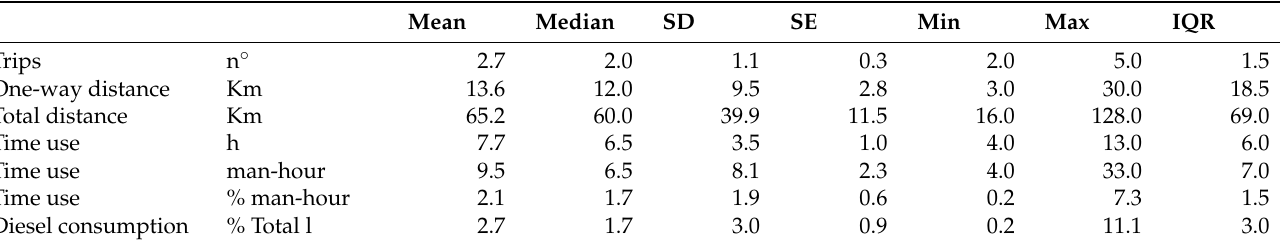
Table 8. Relocation: main descriptive statistics ( n =